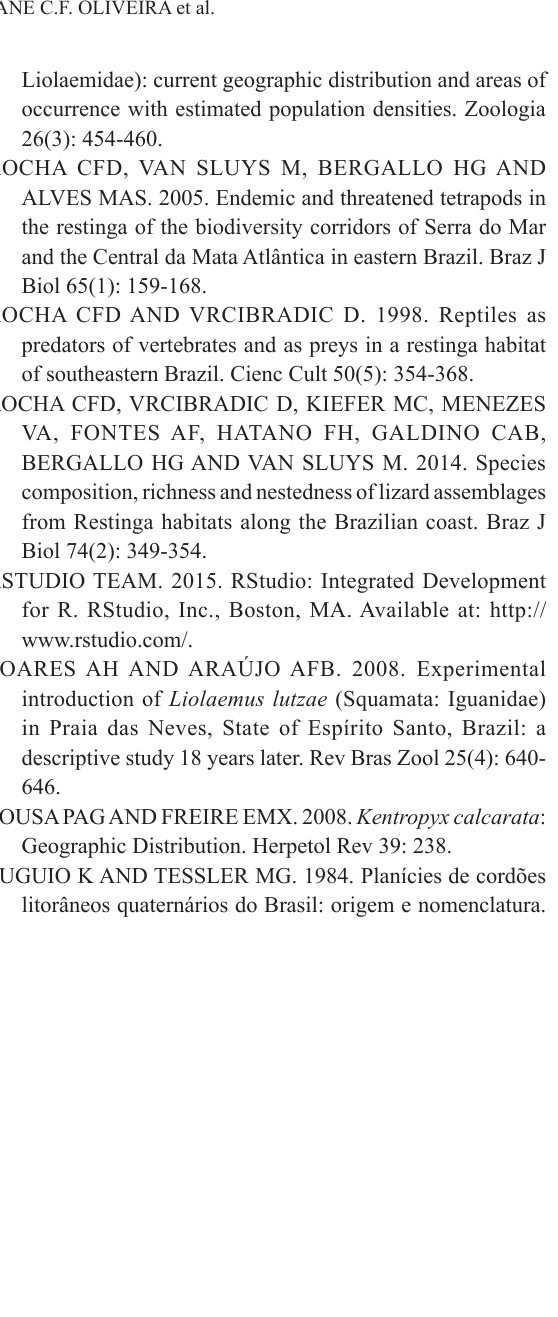
Table SI - Mantel values for comparisons between pairs of restingas in relation to the habitat structure. Table SII - Best models results relating lizard abundance and habitat